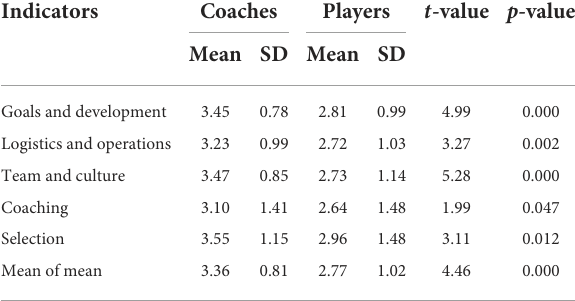
TABLE 1 Descriptive statistics (means and standard deviation) on the prevalence of organizational stressors among football coaches and players.